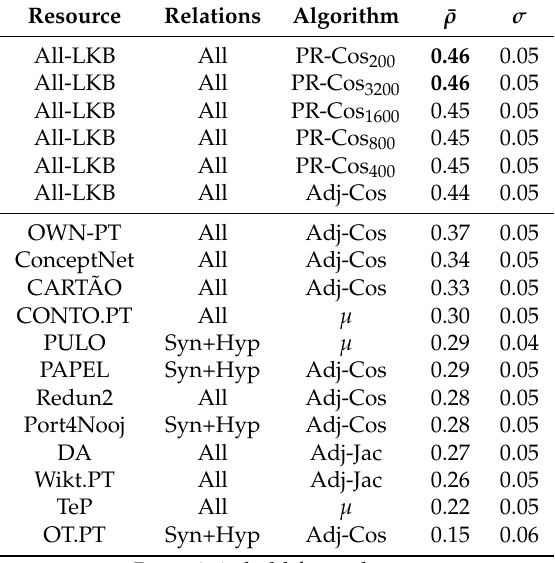
Table 9. Performance overview of LKBs in the WordSim-353 test. Resource